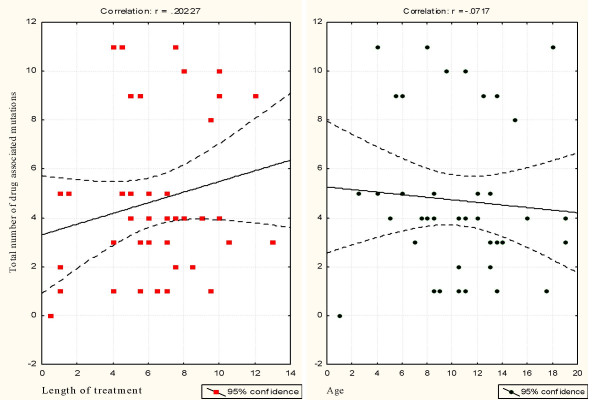
HIV-1 drug resistance mutations correlated with age and duration of ARV therapy (in years).